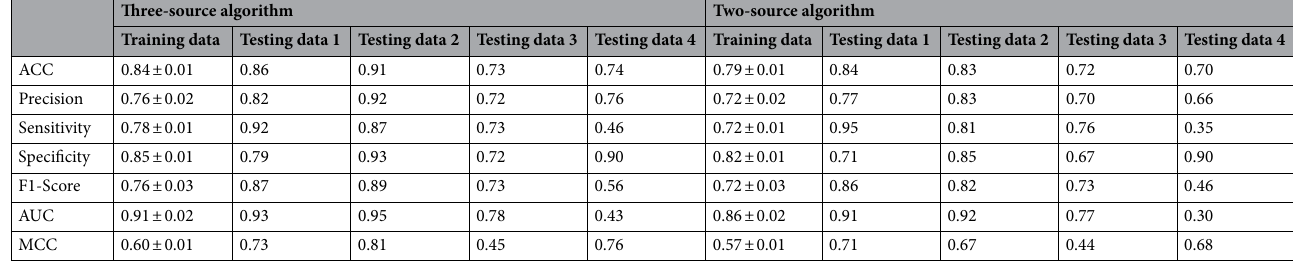
Table 2. The Performance of our method in both two-source and three-source algorithms. Evaluation of training dataset and three testing dataset using AUC (Area Under Curve), ACC (Accuracy), Precision, Sensitivity, Specificity, F1 score together with MCC (Matthews correlation